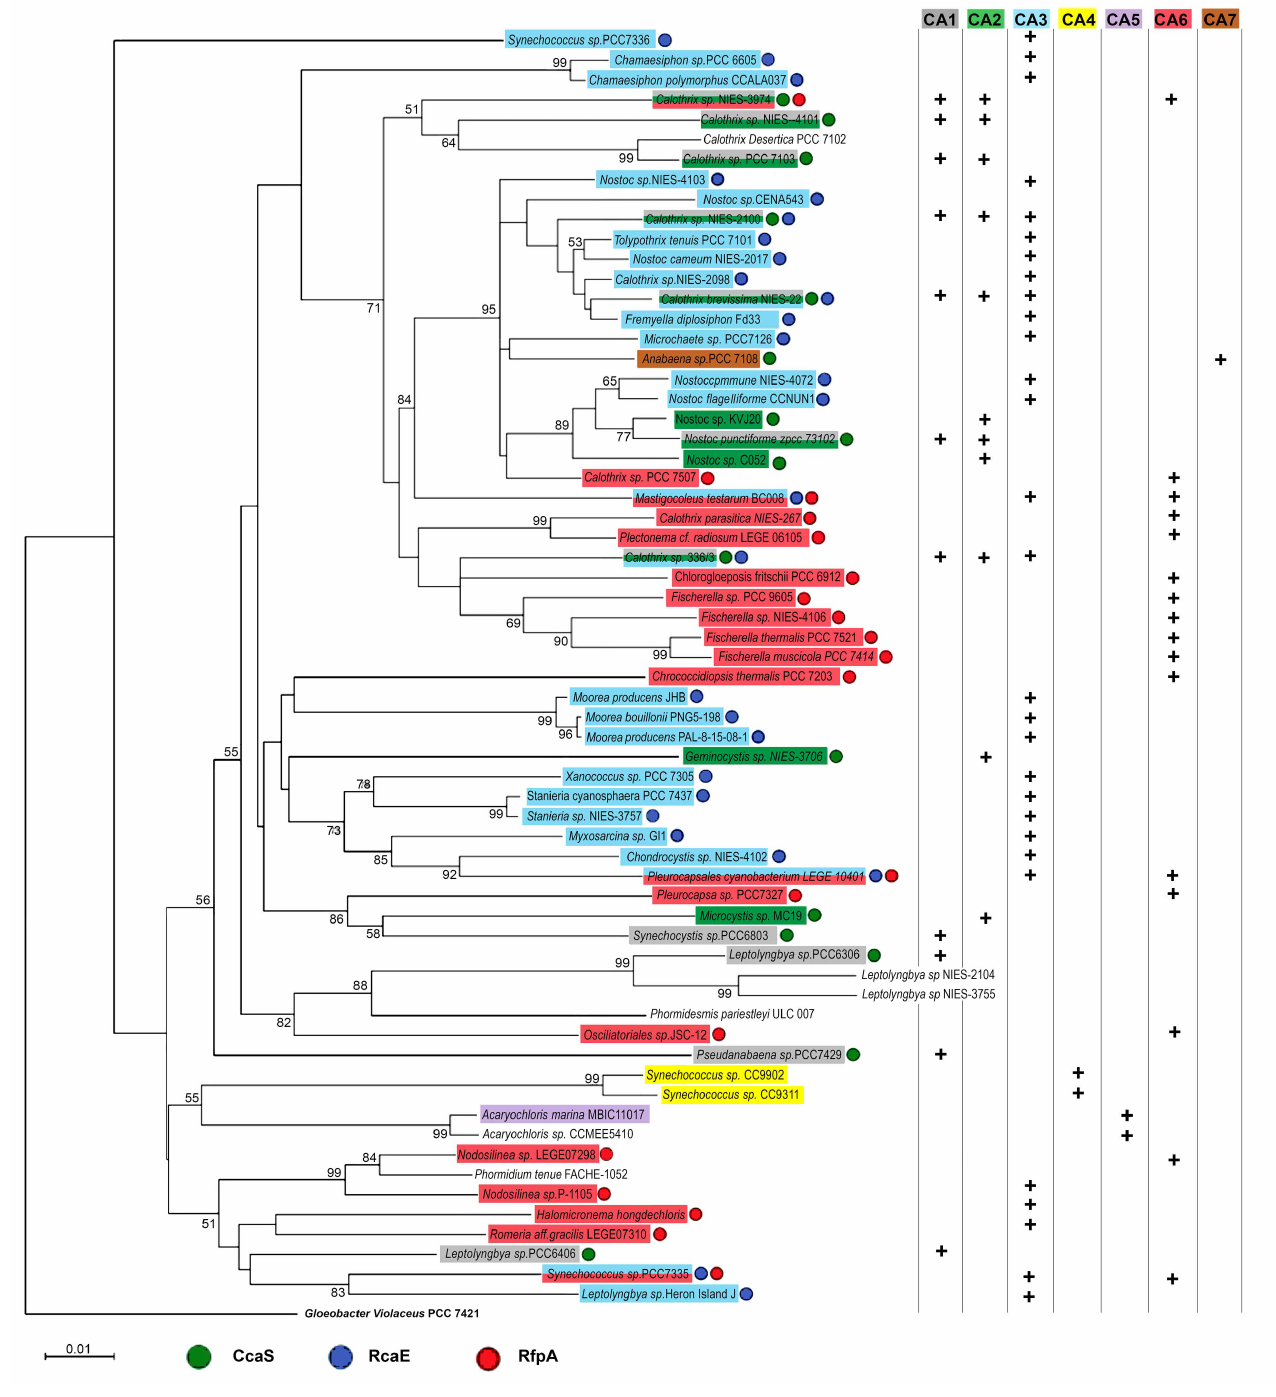
Figure 3. Neighbor-joining phylogeny of selected 65 cyanobacteria based on 16S rRNA sequences and defined chromatic acclimation (CA) types. The CA types are color-coded as CA1, gray; CA2, green; CA3, blue; CA4, yellow; CA5, purple; CA6, red; and CA7, brown. The photoreceptors are illustrated as circles next to the cyanobacterial names and are color-coded as CcaS (Green), RcaE (Blue), and RfpA (Red). The branched groups are supported with a bootstrap of ≥ 50%. The scale bar represents a phylogenetic distance of 0.01 nucleotide substitutions per site. All sequence accessions are listed in Table